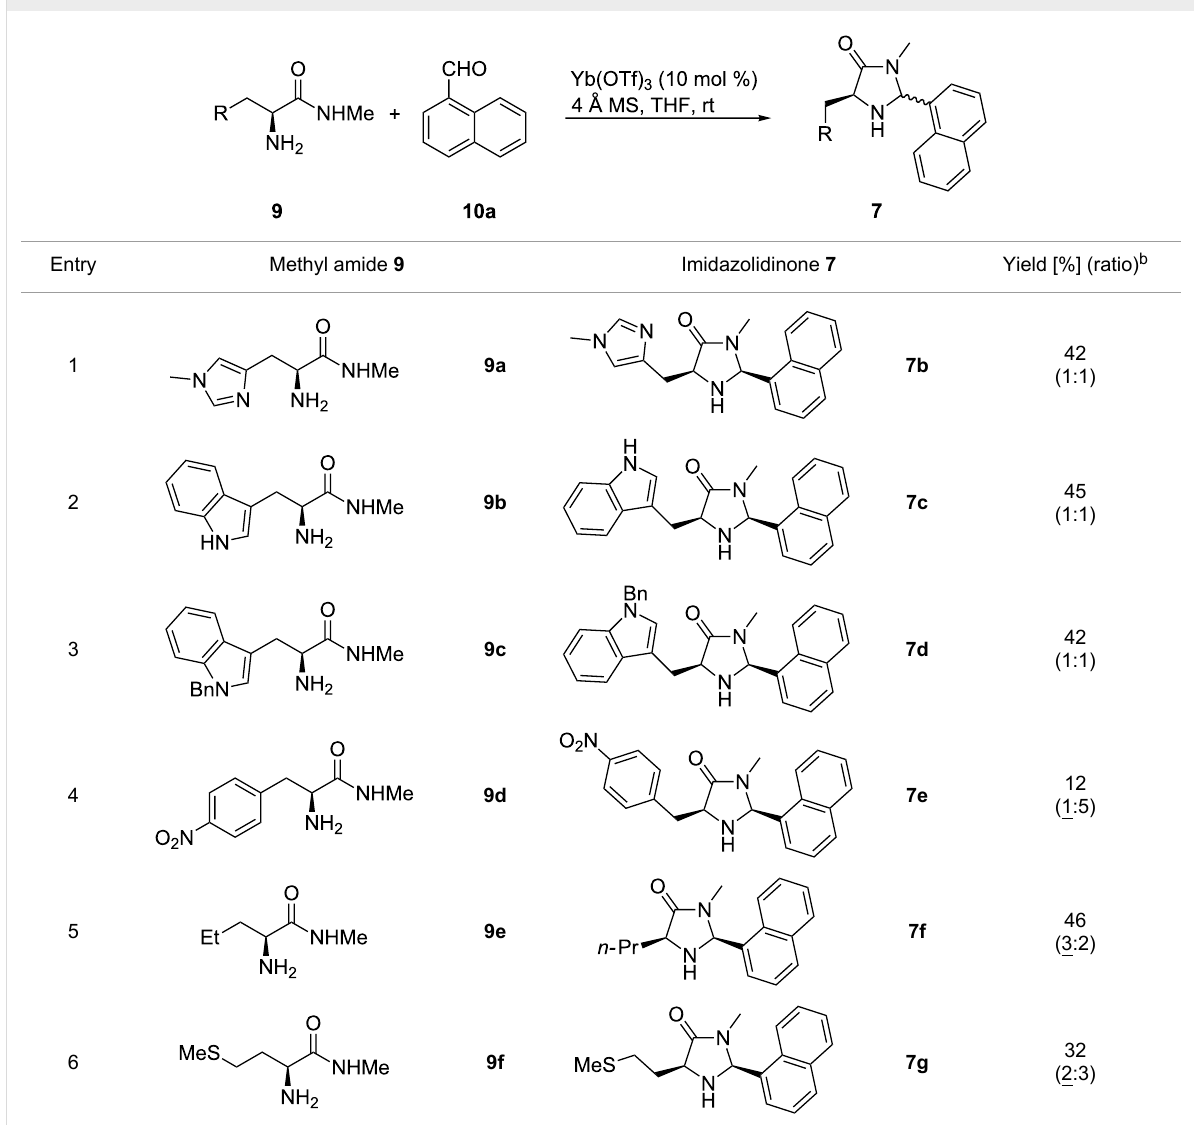
Table 1: Scope of the reaction using 1-naphthyl carbaldehyde ( 10a ).